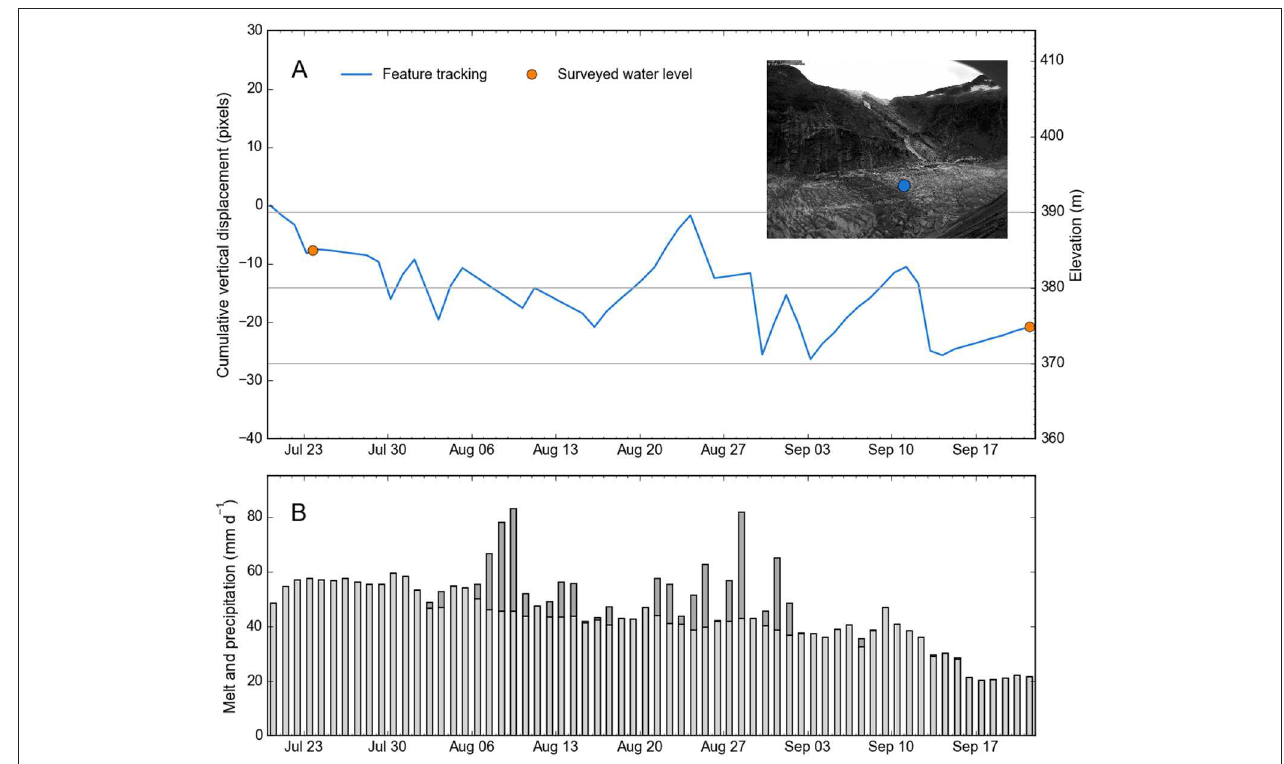
FIGURE 10 | (A) Tracking-derived elevation changes of the floating Suicide Basin ice tongue following the main drainage event from 2018. The blue curve represents the cumulative vertical displacement sampled in the center of the basin (blue dot in the inset image). Two surveyed water levels (orange points) were used to tie pixel displacements into a metric vertical reference frame. Note this is an approximation only. (B) Daily melt (light gray bars) and precipitation (dark gray bars) modeled at the mass balance index site at the basin entrance, indicating decreasing water input into the glacier’s hydrological system over the course of the late summer